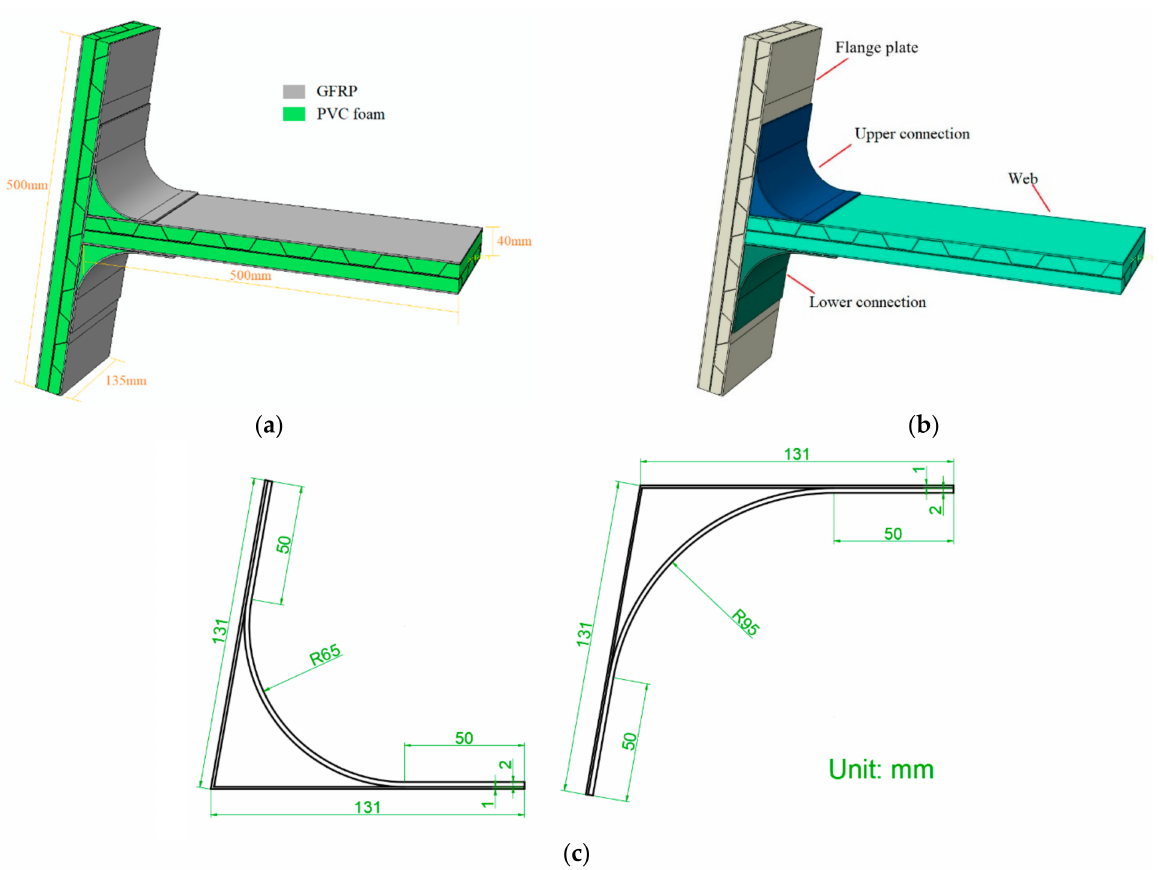
Figure 1. T-joint of composite structure: ( a ) geometry; ( b ) components of the T-joint; ( c ) geometry of the